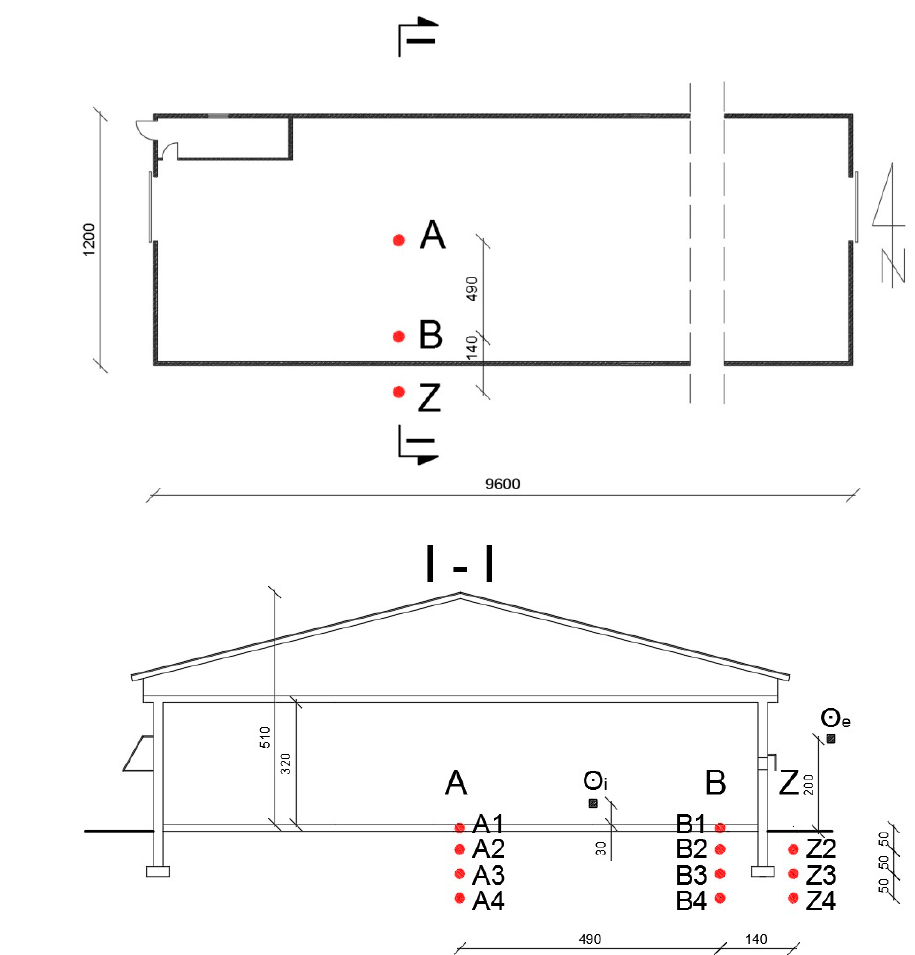
Figure 1. Placement of soil temperature sensors (measuring line A, B, and Z) and indoor ( Θ i ) and outdoor ( Θ e ) air temperature sensors; ( a ) projection; ( b ) cross-section.